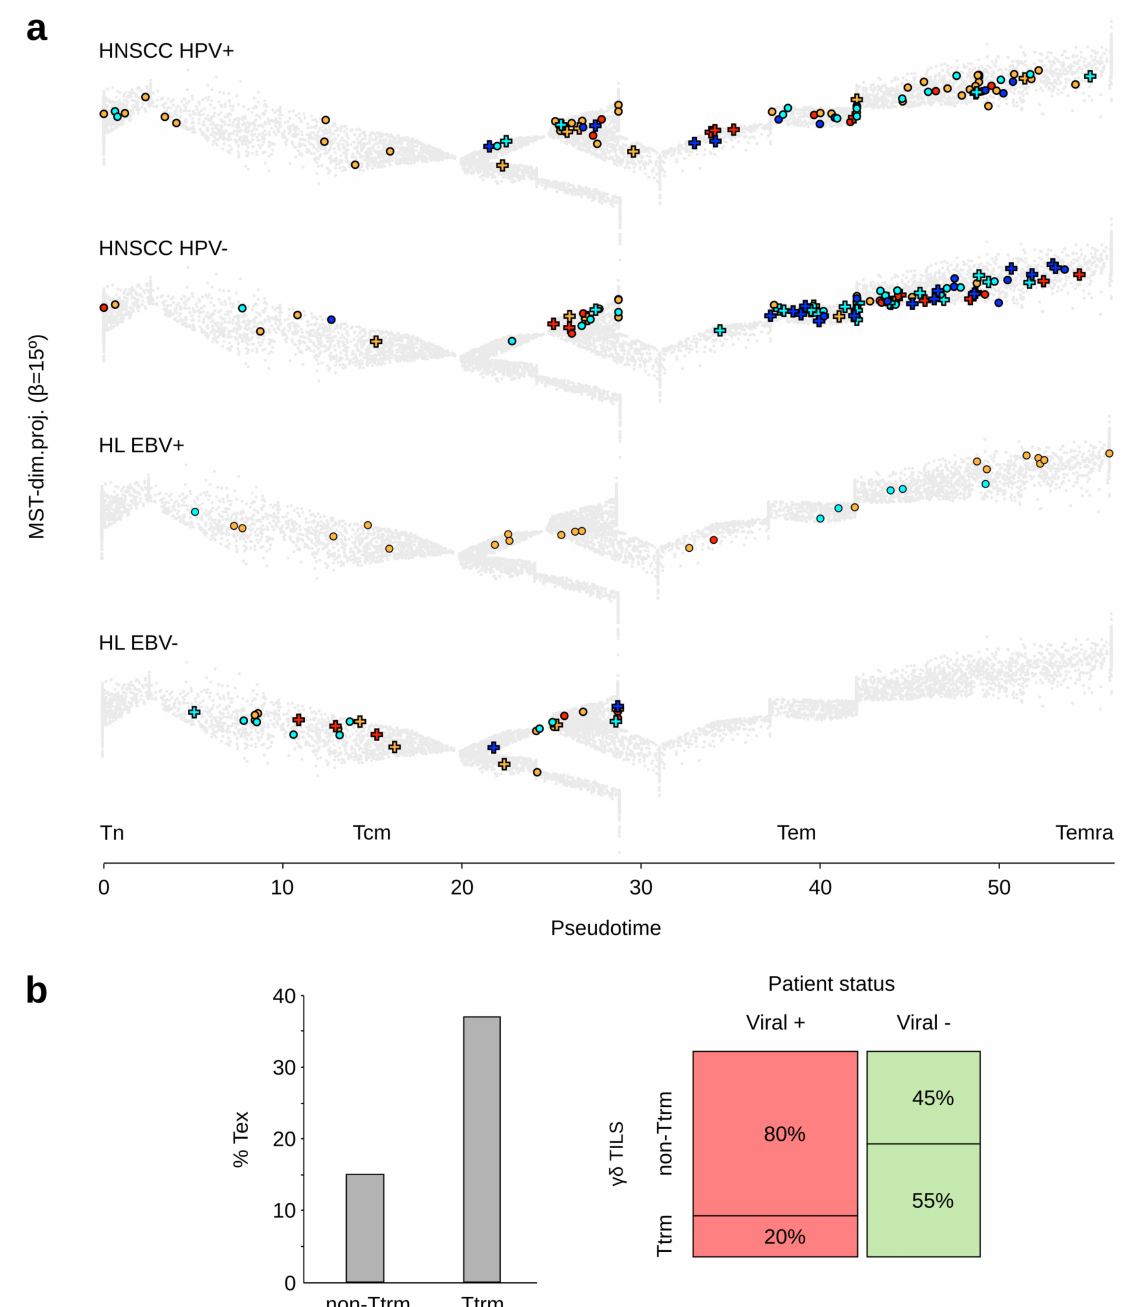
Figure 1. Differentiation and functional hallmarks of γδ T lymphocytes infiltrating HNSCC and HL tumors according to viral status of cancer patients. ( a ) Examples of γδ TILs extracted from representative HNSCC and HL tumors with viral status, overlaid on the public trajectory of γδ T lymphocytes reference (grey). Key: TCRV γ 9 cells (light blue), Tex TCRV γ 9 cells (dark blue), TCRV γ non9 cells (orange), Tex TCRV γ non9 cells (dark red), recirculating (non-Ttrm) cells (open circles), Ttrm (cross). Differentiation pseudotime scale: 0–5: Tn, 5–20: Tcm, 20–50: Tem; > 50: Temra. Together all the EBV-negative HL tumors totalized 53 mostly functional (43/53, 81%) γδ TILs, including 13 Ttrm with 39% of exhausted cells (5/13 Ttrm), while all the EBV-positive HL tumors totalized 60 mostly functional (56/60, 93%) γδ TILs, including 2 non-exhausted Ttrm γδ TILs. The HPV-negative HNSCC tumors totalized 698 mostly functional (489/698, 70%) γδ TILs, including 326 Ttrm with 39% of exhausted cells (127/326 Ttrm), while the HPV-positive HNSCC tumors totalized 357 mostly functional (310/357, 87%) γδ TILs, including 81 Ttrm with 31% of exhausted cells (25/81 Ttrm). ( b ) Right: rates of recirculating and Ttrm among γδ TILs (both subsets) per viral status of patients (pooled); left: rates of exhausted cells among the recirculating and Ttrm γδ